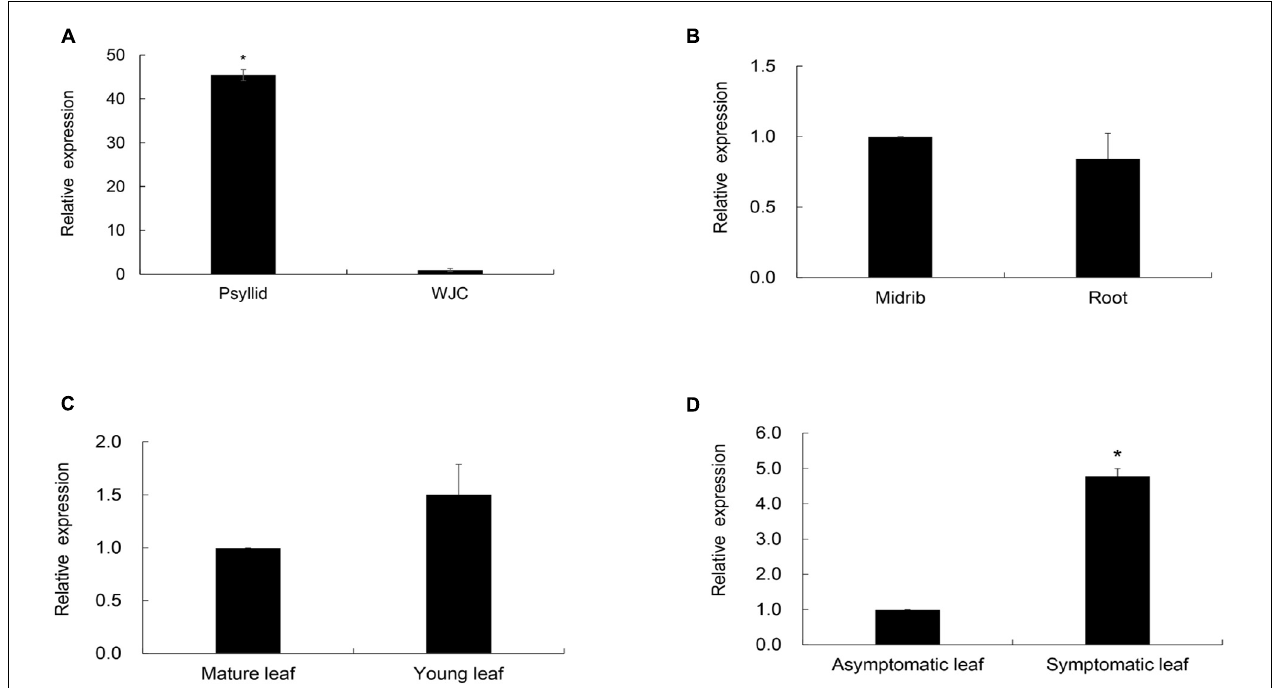
FIGURE 4 | Transcription levels of CaLasSDE115 in Wanjincheng (WJC) orange and psyllids. Psyllid RNA was isolated from psyllid fed by Ca Las-infected sweet orange for 3 weeks, and citrus RNA was isolated from Wanjincheng orange tissues infected by Ca Las for 1 years. Using CaLasgyrA gene (GenBank No. CP001677.5) gene as internal reference, relative expressions in (A) psyllids, (B) root, (C) young leaf and (D) symptomatic leaf were determined compared to WJC orange, root, midrib, mature leaf and asymptomatic leaf, respectively. The Ct values of CaLasSDE115 and CaLasgyrA are listed in Supplementary Table 2 . Values are expressed as means ± standard deviation of three independent tests. *on top of the bars indicates a significant difference ( p < 0.05, Student’s t -test).